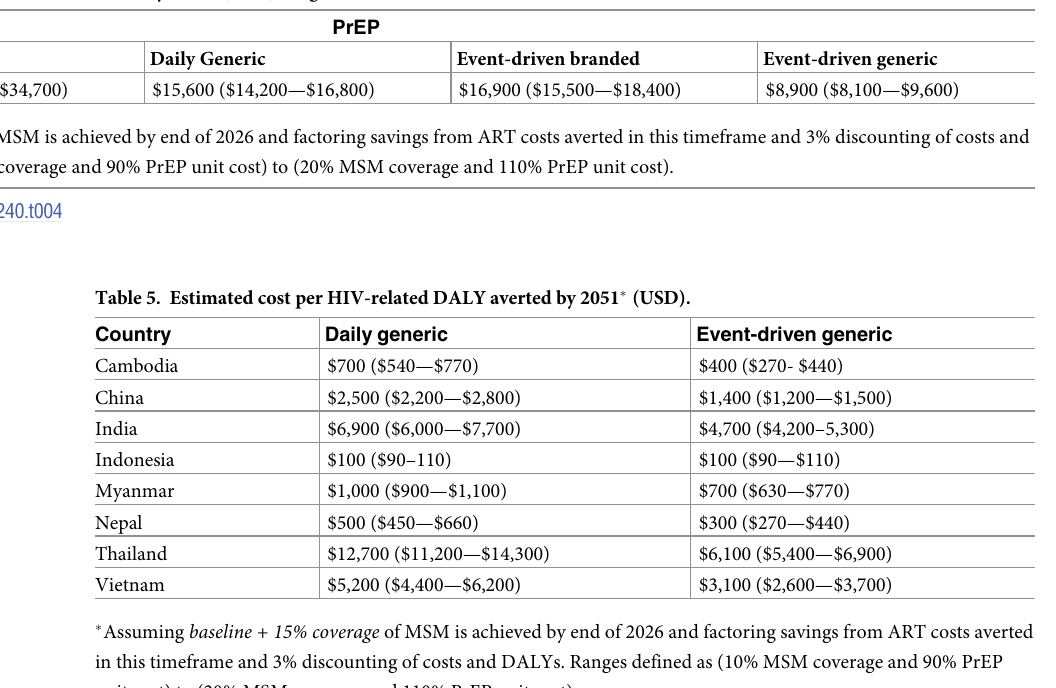
Table 4. Estimated cost per HIV-related DALY averted by 2031 � (USD) for generic and branded PrEP in China.